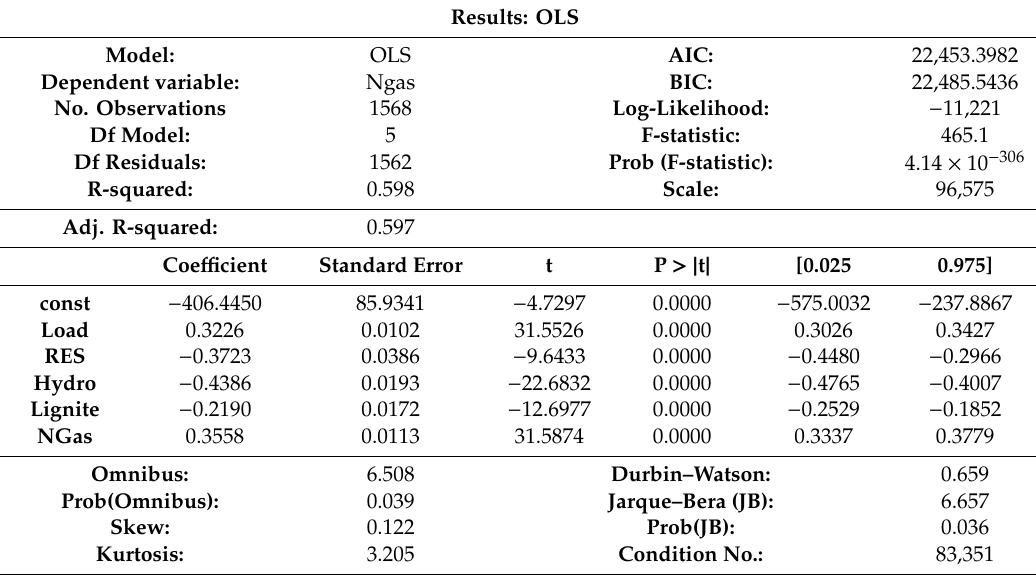
Table A3. Coe ffi cients for the long-run equilibrium relationship for hour 00:00. Results: OLS